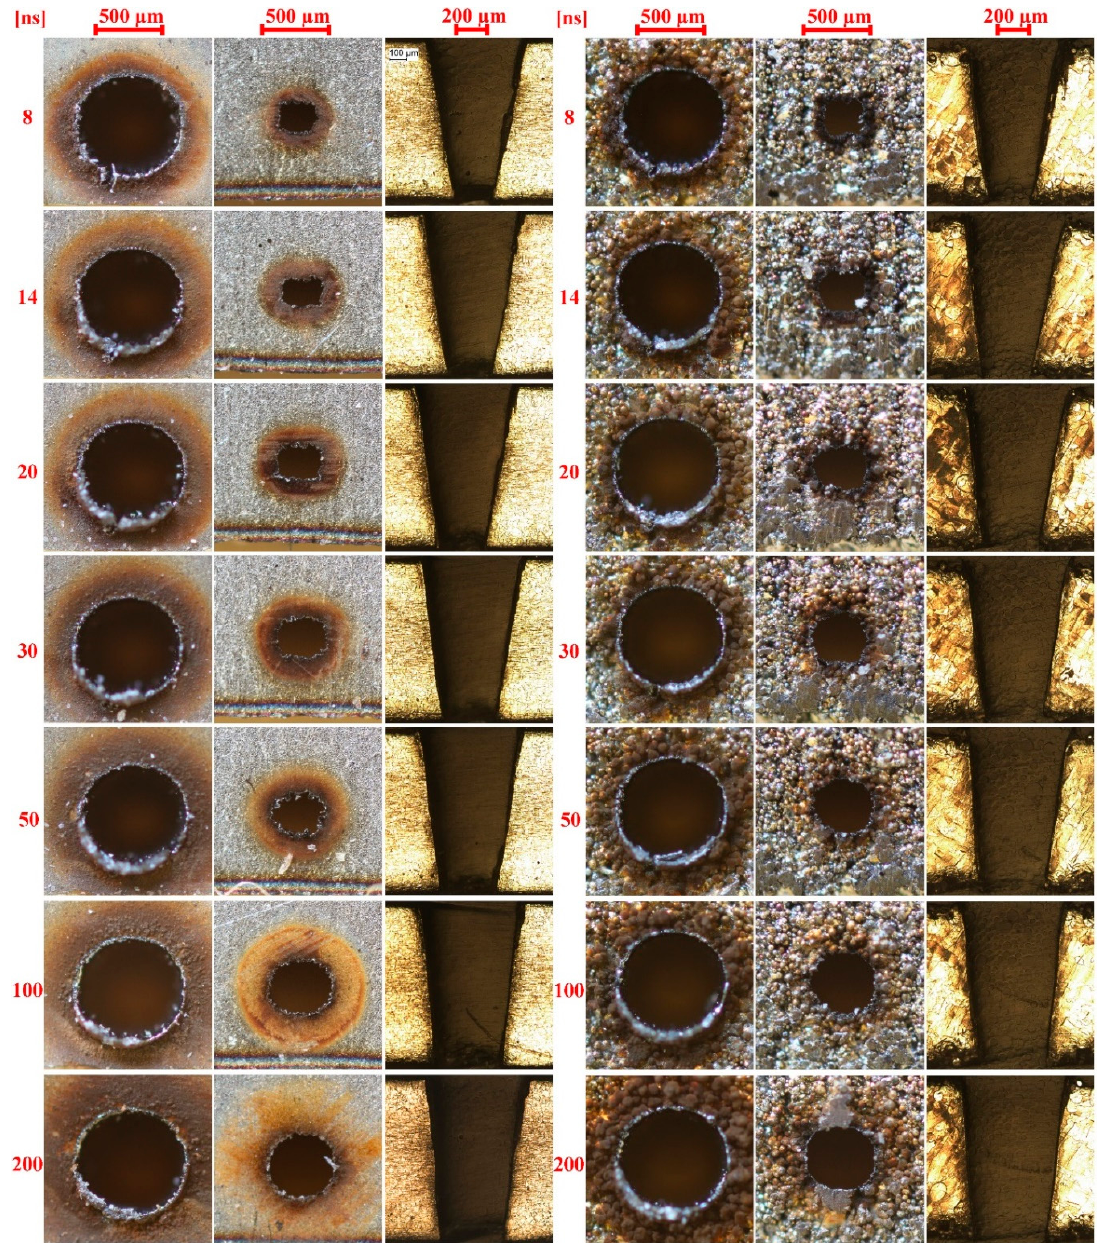
Figure 5. Magnified images of the entry and exit holes, and hole profiles, respectively, for all drilled holes. Cold-rolled sheet images are on the left, and images from the PBF sheet are on the right.